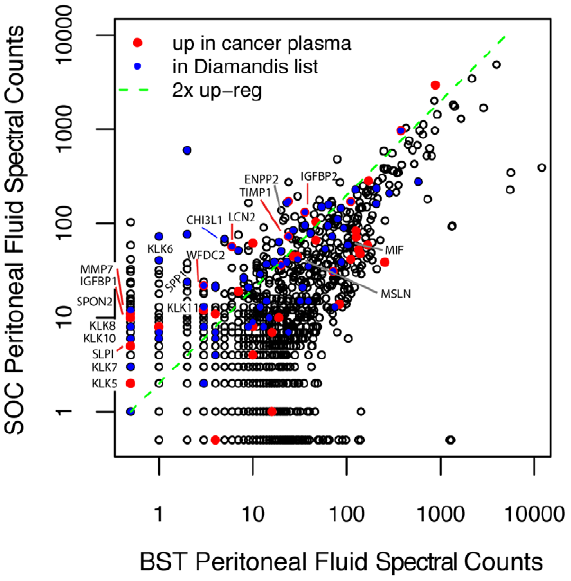
Figure 2. Comparison of peptide counts from peritoneal fluid experiments. Red points are up-regulated in SOC serum. Blue points are proteins observed in ovarian cancer ascitic fluid by Kuk et al [34]. Benchmark proteins are labeled. Points above green dashed line are considered up-regulated in peritoneal fluid.